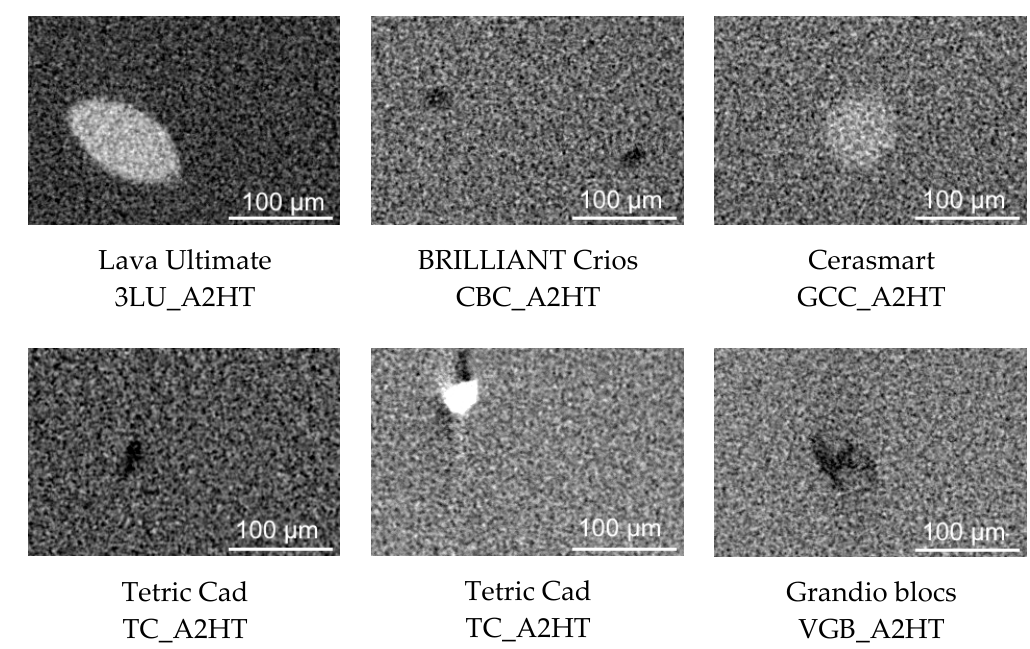
Table 4. No discontinuities were identified for CAD/CAM RBCs that are not displayed in Table 4.